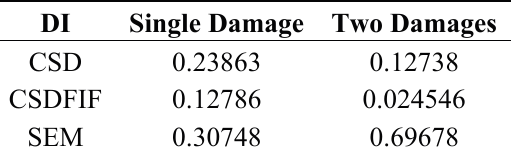
Table 1. MDDE of the wind turbine